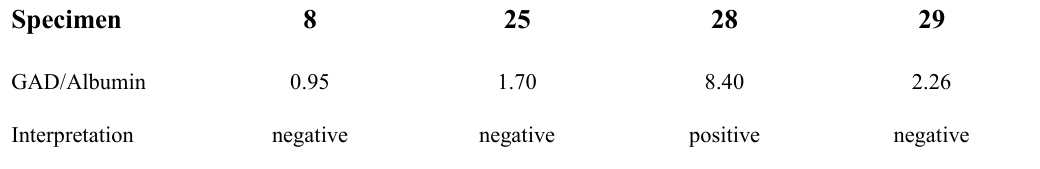
Table 1. The intensity of the peak at 65 kDa for specimen 28 is 8.40x the intensity of the corresponding peak for albumin. This serum results from a child with diabetes mellitus type 1 at an early